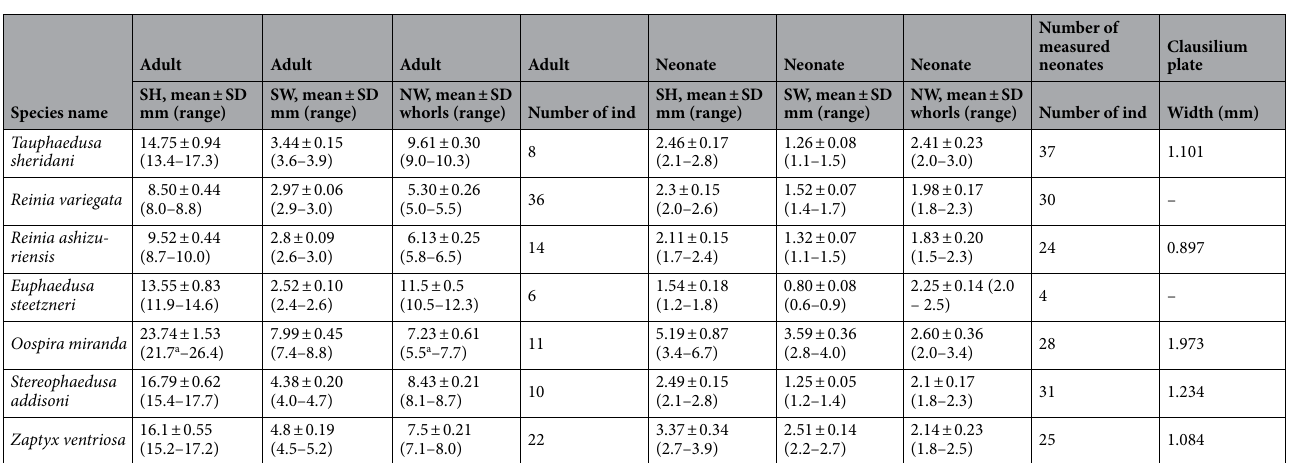
Table 1. Shell size of studied Phaedusinae species. Measurements based on adult individuals kept in laboratory colonies and freshly produced juveniles. Width of clausilium plate measured in virtual microCT models. SH shell height, SW shell width, NW number of whorls. a Decollated